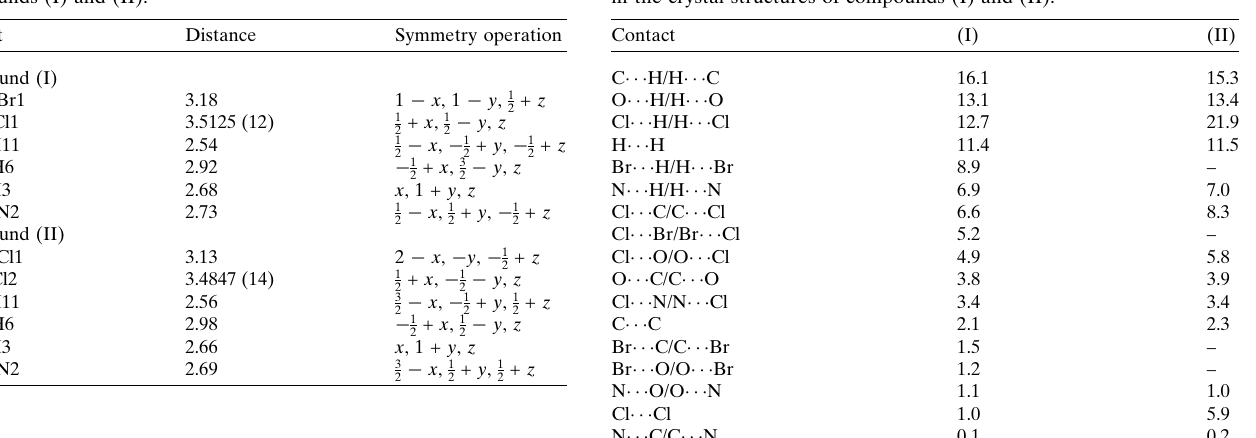
Table 4 Percentage contributions of interatomic contacts to the Hirshfeld surface in the crystal structures of compounds (I) and (II).